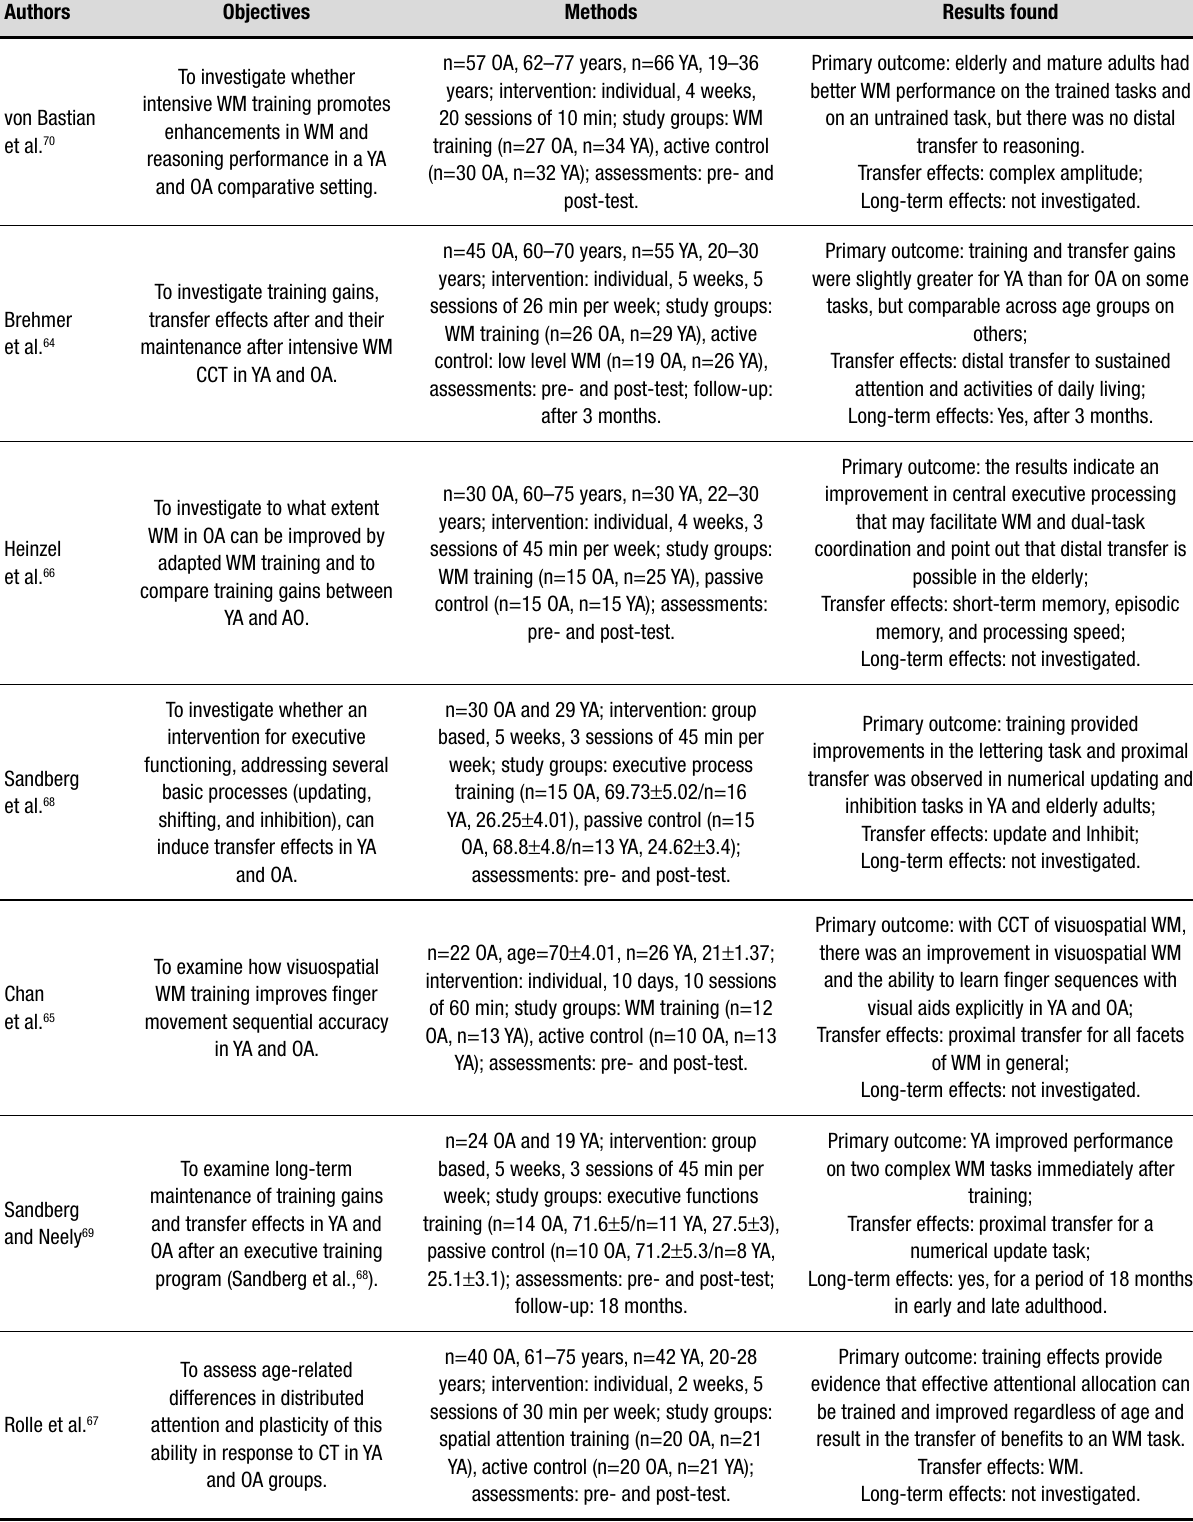
Table 2. Studies comparing older and younger